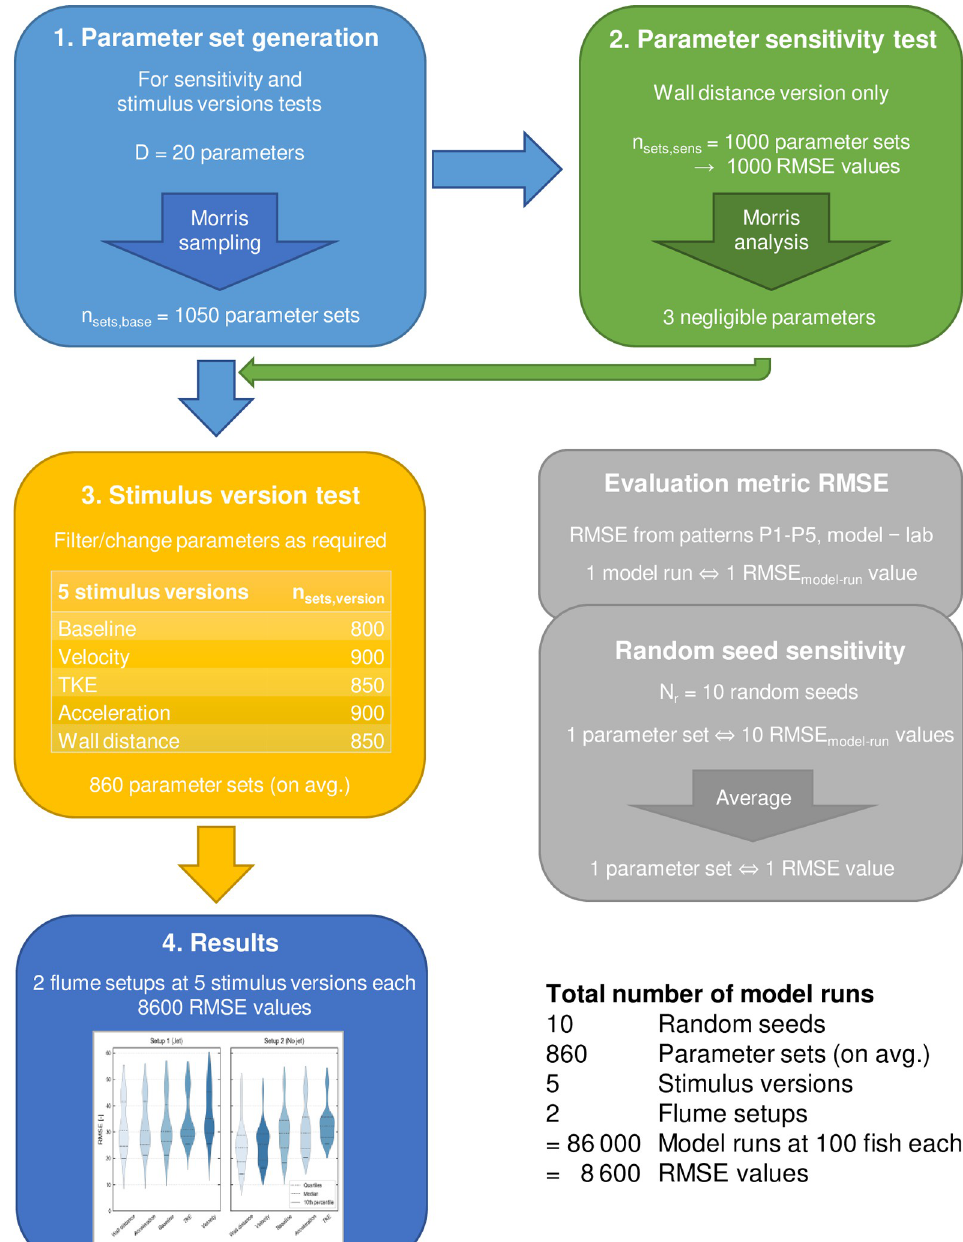
Fig 3. The process of testing our behavioral model. The process starts with the generation of varying parameter sets, which are used for testing parameter sensitivity and contrasting stimulus versions in the following. Each box corresponds to one text